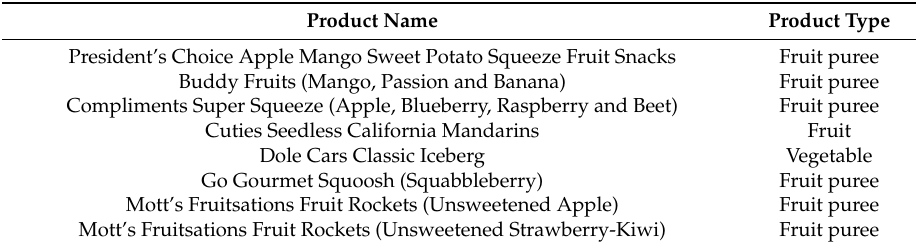
Table 2. Child-targeted food products classified as foundational foods according to Health Canada model ( n = 8 out of 374 products).